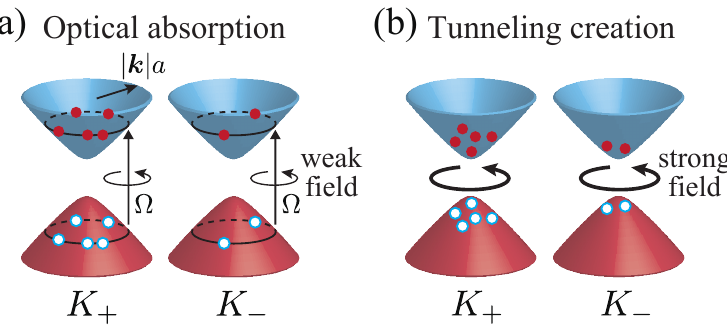
Figure 3: Perturbative versus Nonadiabatic opto-valley polarization in 2D gapped Dirac fermion: Schematic picture of pair excitations at the two valleys through two mechanisms. (a) In optical absorption, the pairs are concentrated on an equal energy curve ∆ E ( k ) = Ω due to energy conservation. (b) In tunneling creation, the pairs are produced according to Eq. (17) (see Fig. 4).